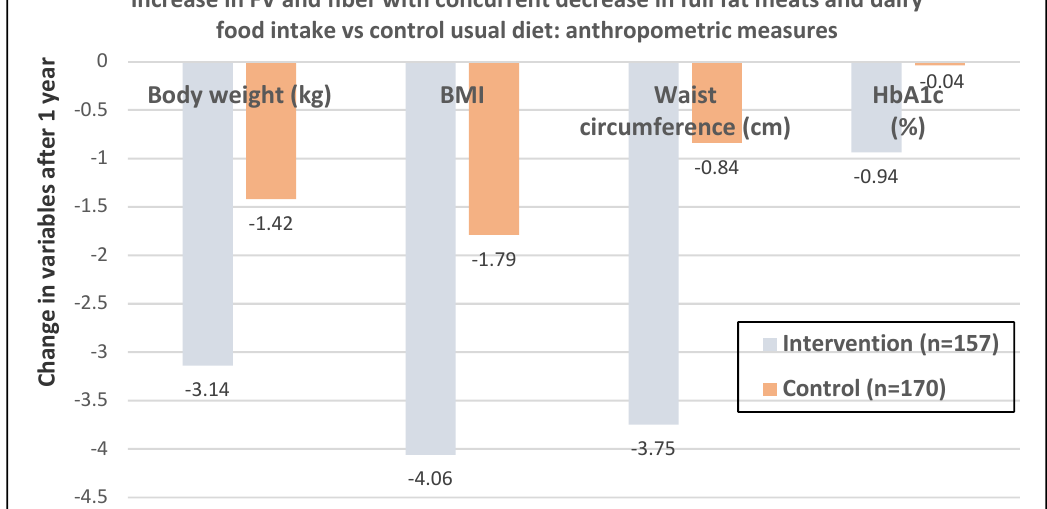
Figure 27. RCT of 327 young overweight and obese women (mean age 34 years). A significant increase in consumption of fruit and vegetable (FV) and fiber along with decreased intake of meat and dairy products, total dietary fat and refined carbohydrates led to reduction of total energy intake by −342 kcals/day in the healthy diet education group resulting in significantly more loss of weight, BMI, and WC than shown in the usual diet control women over 12 months ( p < 0.05) [81]. Nutrients 2020 , 12 , x FOR PEER REVIEW